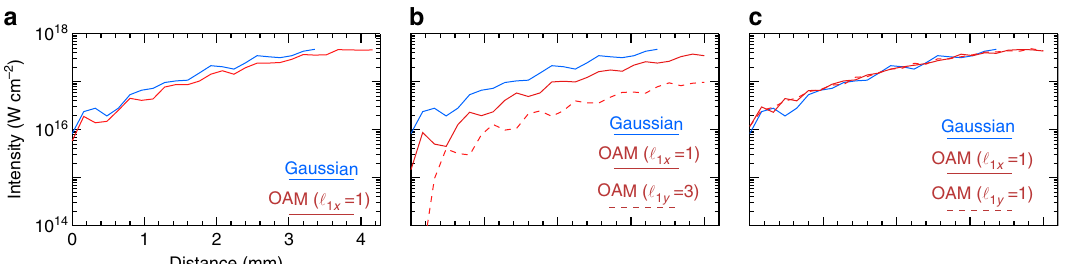
Figure 2 | Simulation results showing the generation and amplification of OAM lasers. Blue refers to the amplification of a Gaussian seed by a Gaussian pump. The initial laser configuration in each panel ( a – c ) corresponds to the initial set-up illustrated by each corresponding panel ( a – c ) in Fig. 1. ( a ) The amplification of a seed with ‘ 1 x ¼ 1 using a long Gaussian pump (red). ( b ) The generation and amplification of a new OAM mode with ‘ 1 y ¼ 3 (dashed red) and of an existing mode with ‘ 1 x ¼ 1 (solid red) from an OAM pump polarized in two directions with ‘ 0 y ¼ 2 and ‘ 0 x ¼ 0. ( c ) The amplification of a new OAM mode with ‘ 1 ¼ 1 from a TEM seed with no net initial OAM and from a Gaussian pump. See Table 1 for simulation parameters.